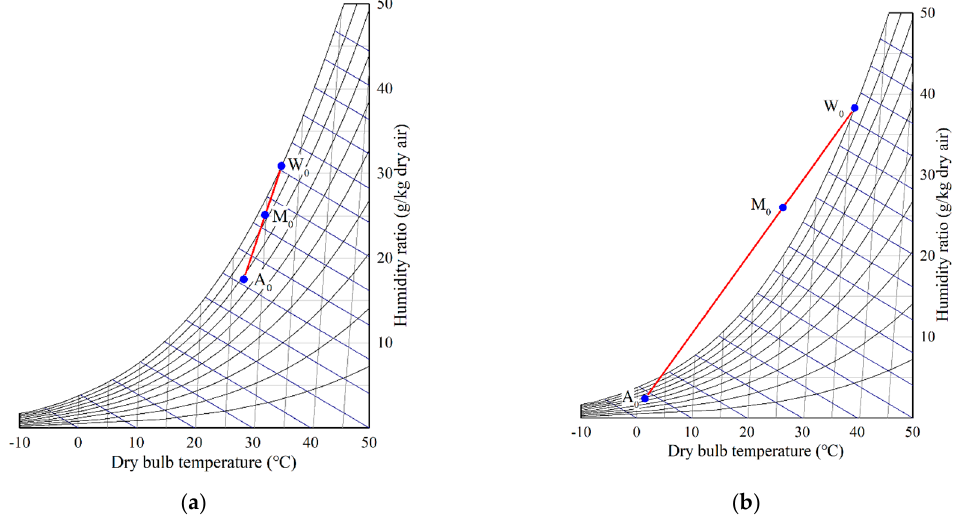
Figure 1. Thermodynamic process. ( a ) Summer operation. ( b ) Winter operation.